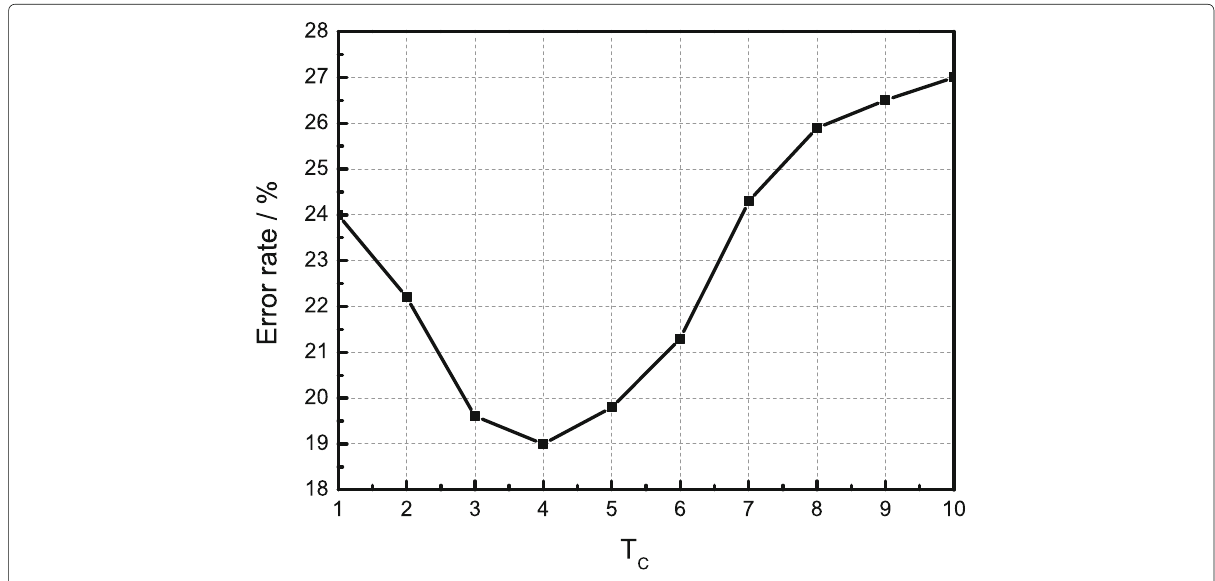
Fig. 9 Estimation error rate under different T